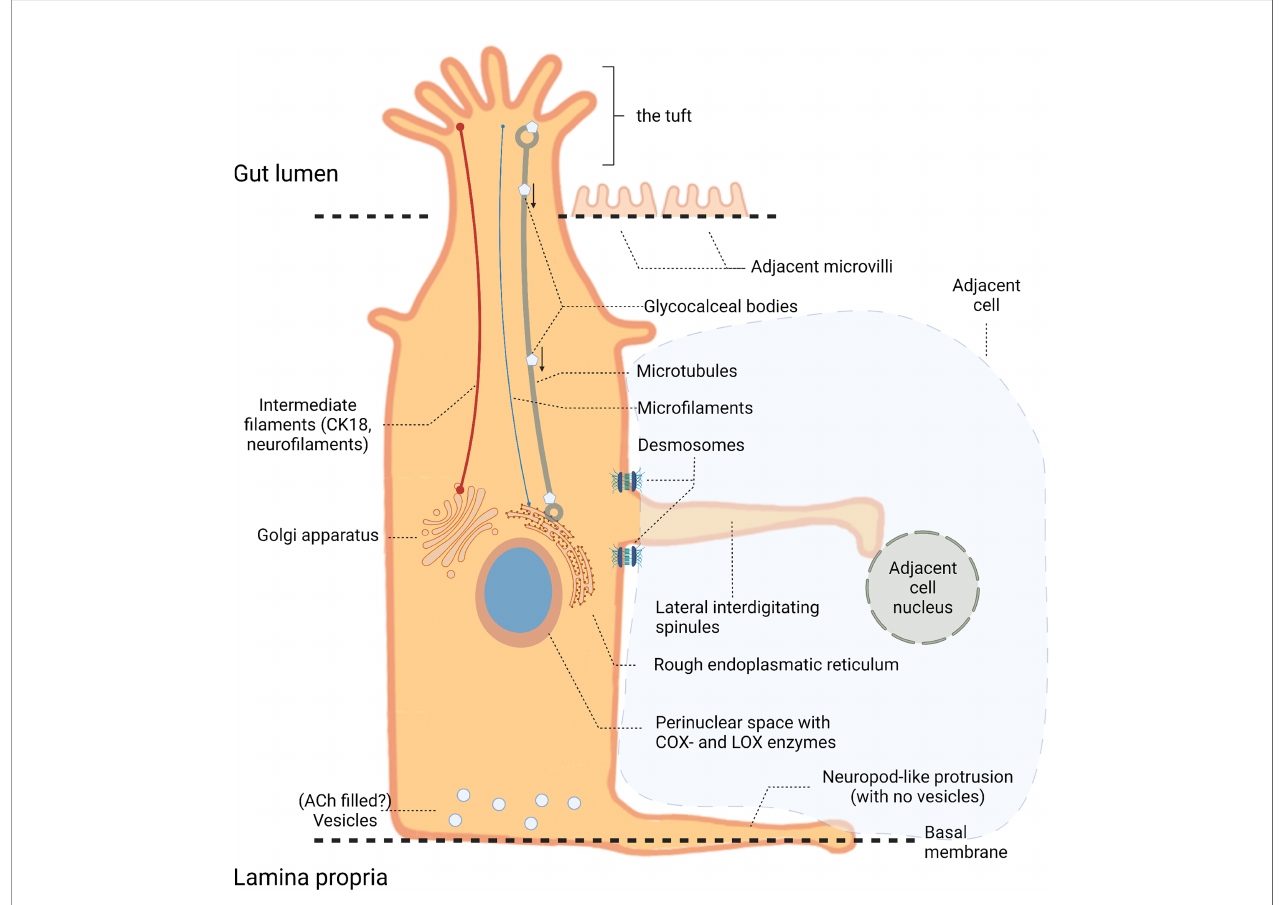
FIGURE 1 | Tuft cell (TC) anatomy. Illustration of a TC located in the intestinal epithelium with its long apical microvilli (the “ tuft ” ) extending into the gut lumen. Within the cell these microvilli associate with microtubules and micro fi laments that extend towards the nucleus connecting to the perinuclear rough endoplasmic reticulum and Golgi apparatus. Intermediate fi laments, such as cytokeratin-18 (CK18) and neuro fi laments, contribute to the cytoskeletal make-up. At the nucleus level, cytoplasmic (or lateral interdigitating) spinules extend from the lateral TC border reaching the nuclei of neighboring cells. The basal part of TCs contains vesicles, unlike the neuropod-like protrusions extending towards the basal